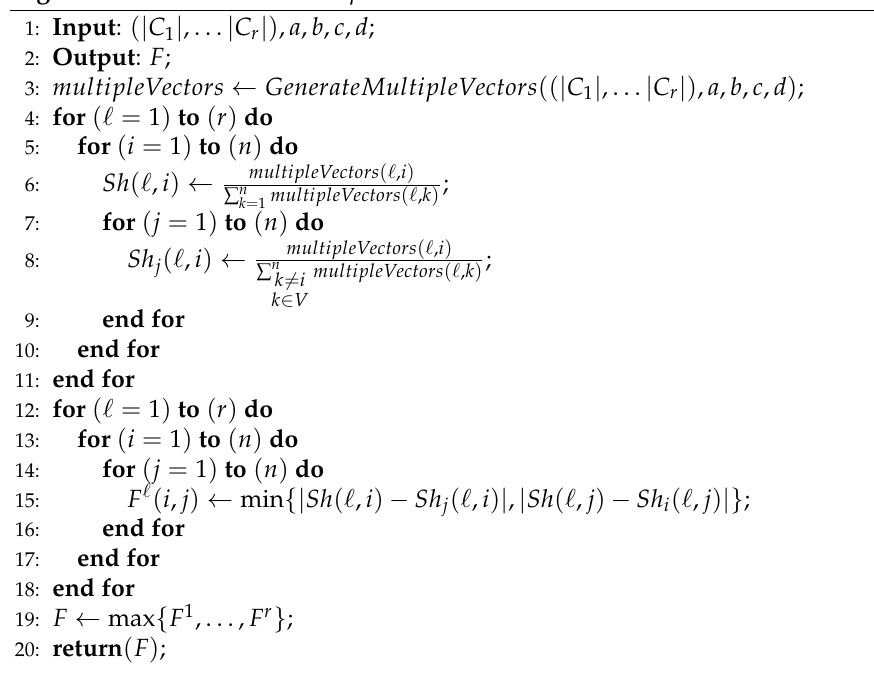
Algorithm 8 Matrix From Multiple